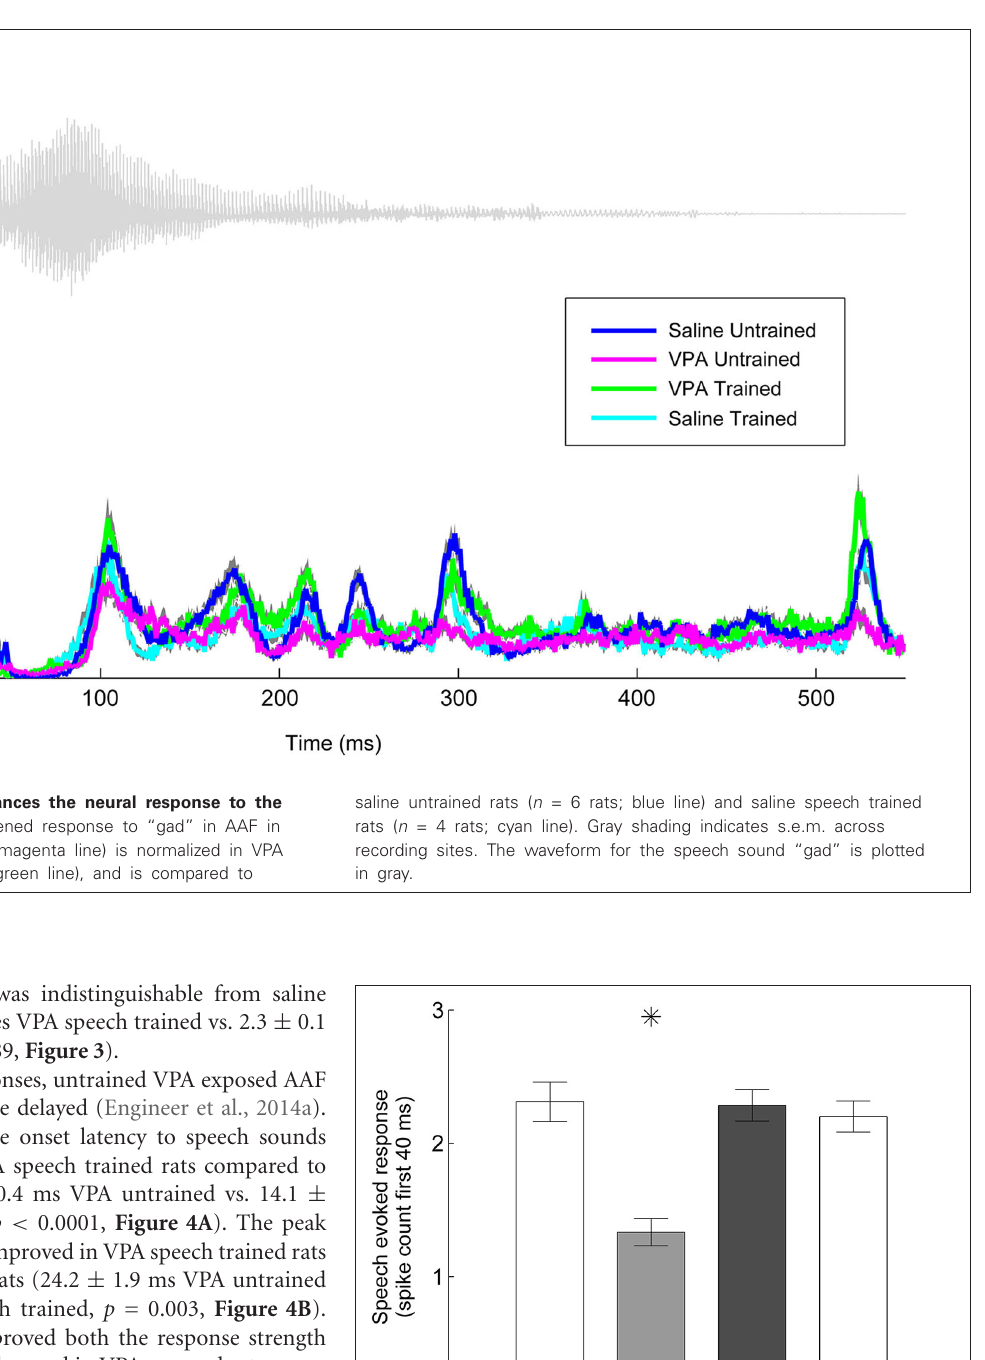
FIGURE 3 | Mean spike count in response to speech sounds is restored in VPA speech trained rats compared to VPA untrained rats . The number of driven spikes is the average of the 40 ms onset response across the 11 speech sounds presented. Error bars indicate s.e.m. across AAF recording sites. Asterisks indicate groups that are statistically significant compared to VPA speech trained rats ( p <